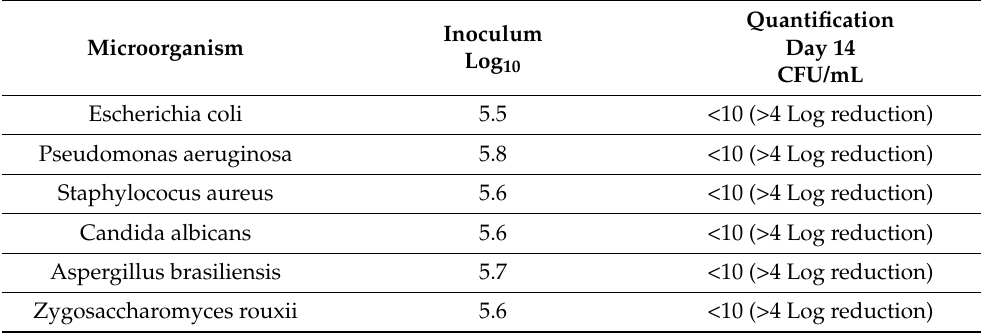
Table 5. Results of Antimicrobial Effectiveness.